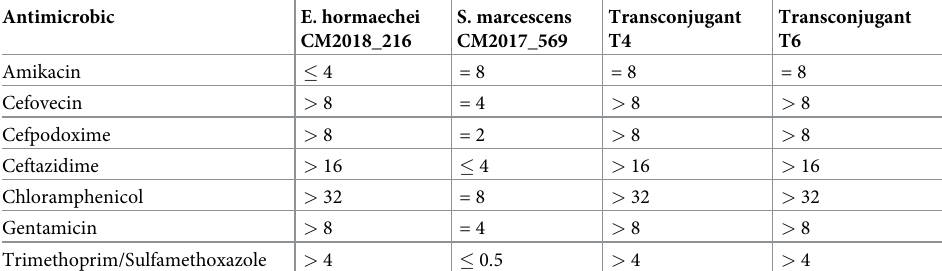
Table 7. Comparison of MICs values ( μ g/mL) of donor strain E . hormachei CM2018_216, recipient strain S . mar- cescens CM2017_569 and 2 Serratia transconjugants T4 and T6, demonstrating the occurrence of transfer of resis- tance in vitro .